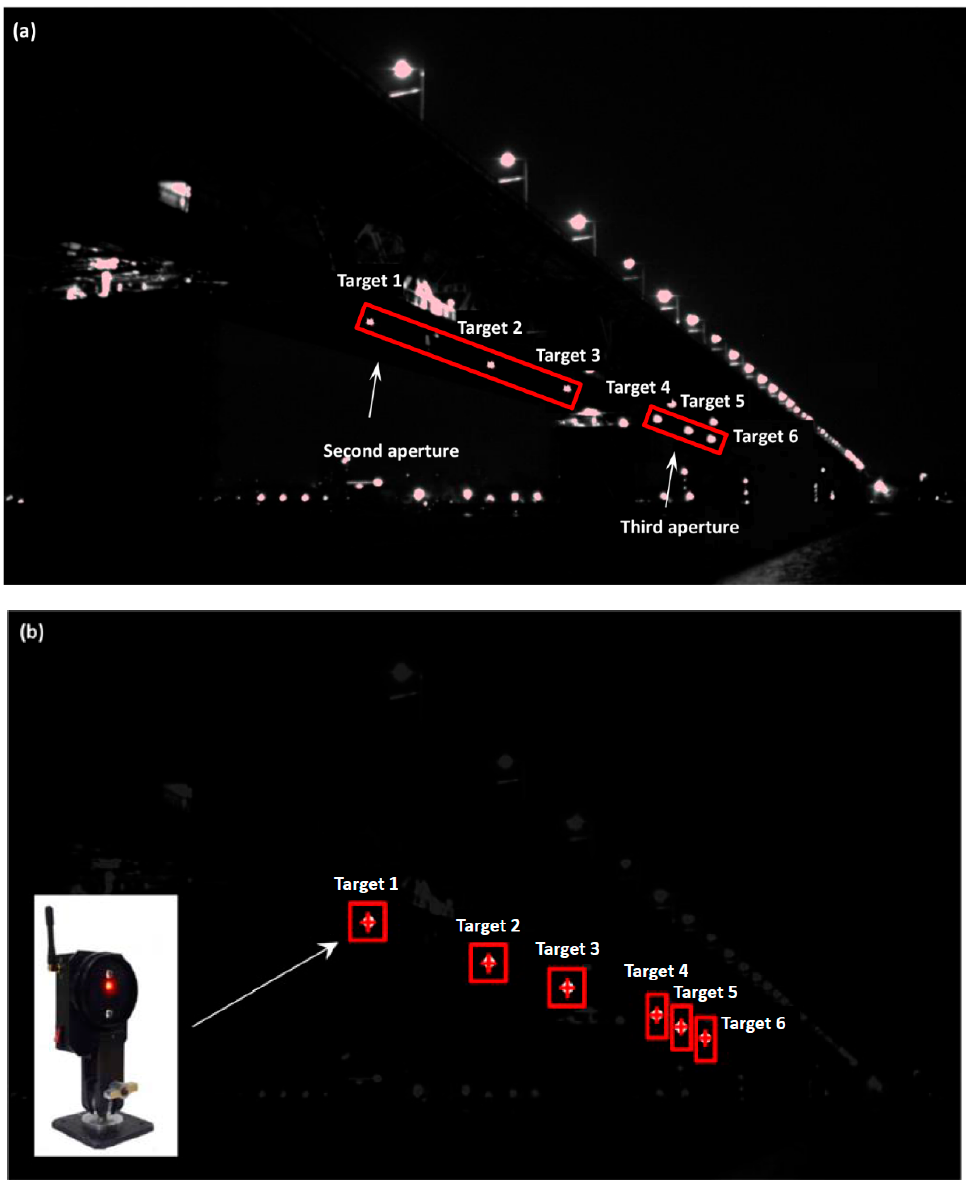
Figure 7. The digital images of the Wuhan Yangtze River bridge ( a ) without; and ( b ) with using the bandpass optical filter. The red rectangles are the subsets centered at the six LED targets.